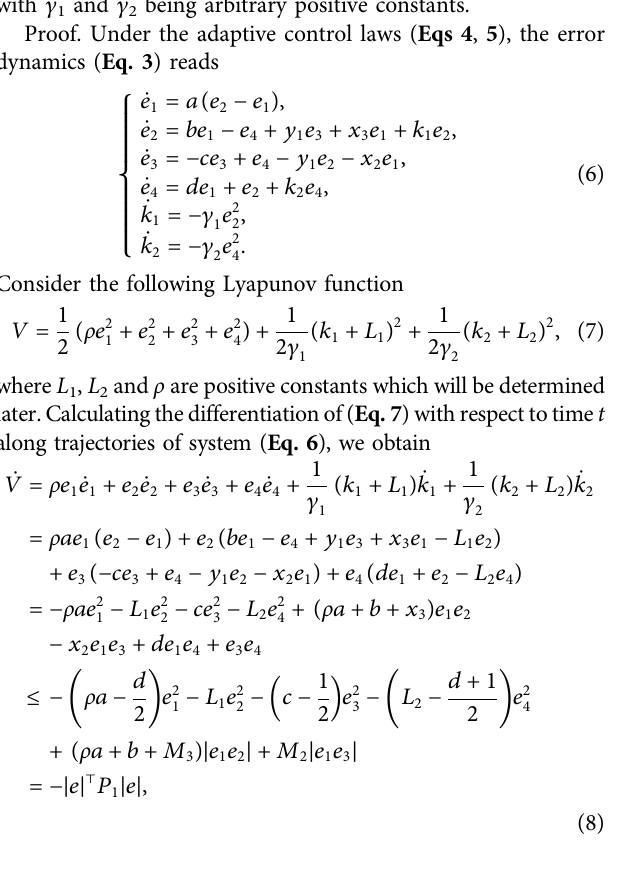
Frontiers in Physics |